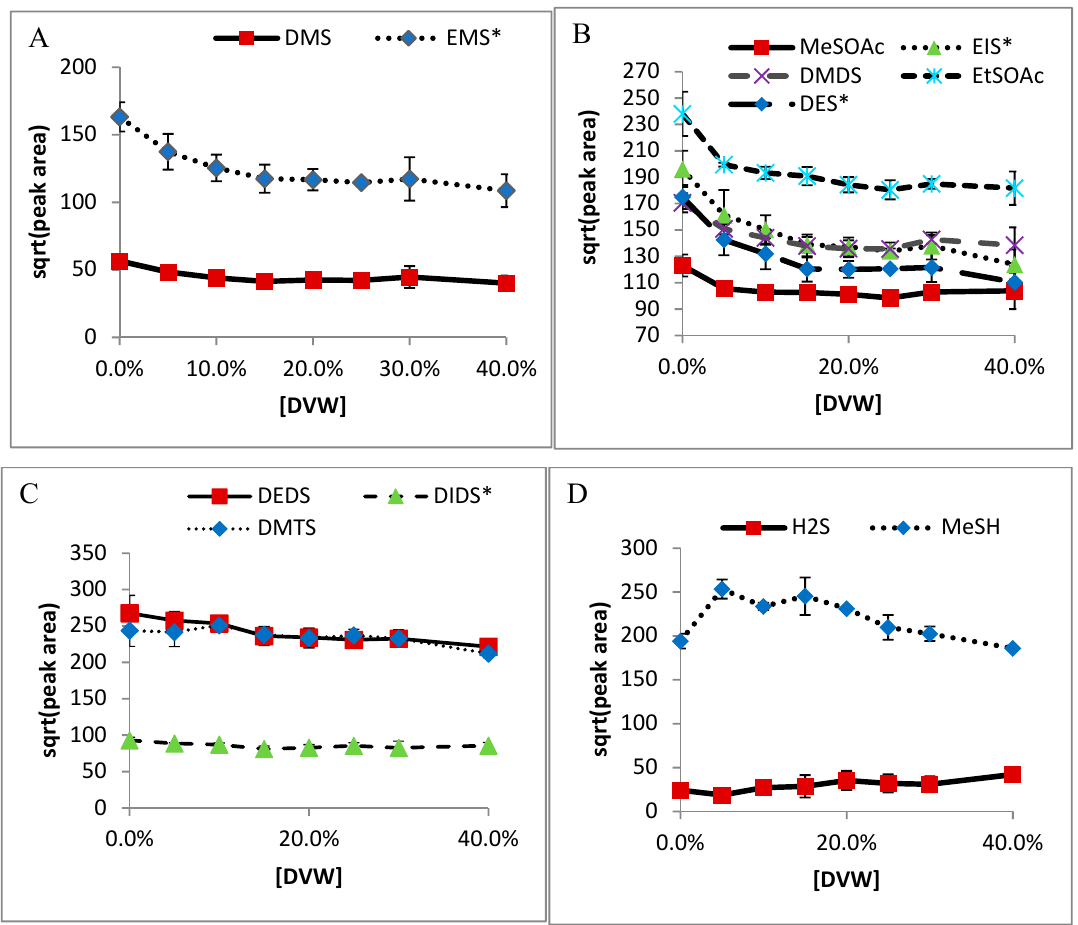
Figure 1. Effect of devolatilized Chardonnay wine matrix (DVW) on HS-SPME GC-PFPD analysis of: ( A ) DMS and EMS (IS), ( B )MeSOAc, DMDS, EtSOAc, DES (IS), and EIS (IS), ( C ) DEDS, DMTS, and DIDS (IS), ( D ) H 2 S, and MeSH.